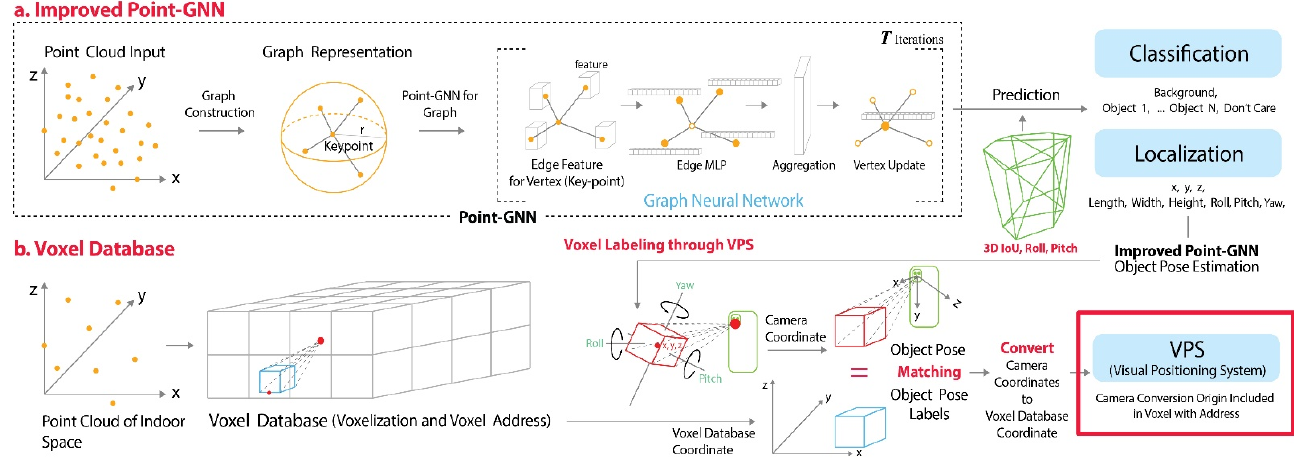
Figure 2. Overview of the proposed visual positioning method (VPS). The process comprises ( a ) pose estimation stages of improved point-graph neural network (GNN) and ( b ) voxel database construction along with voxel labeling matching through VPS.